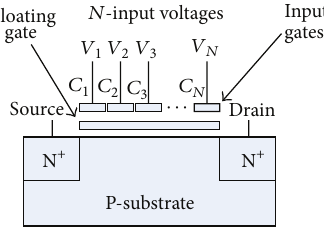
Figure 1: A cross-sectional view of N-type, 𝑁 inputs